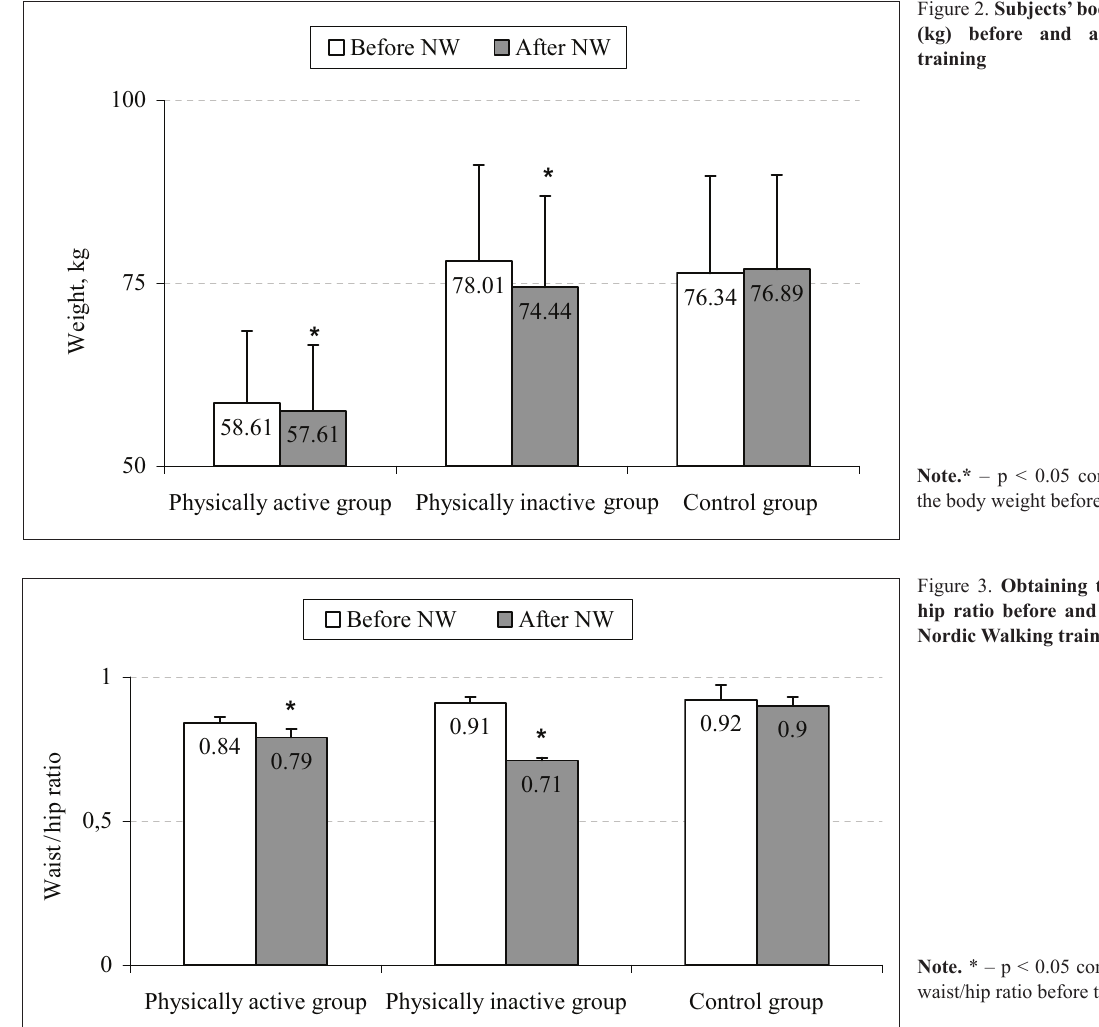
Note. * – p < 0.05 compared to waist/hip ratio before the